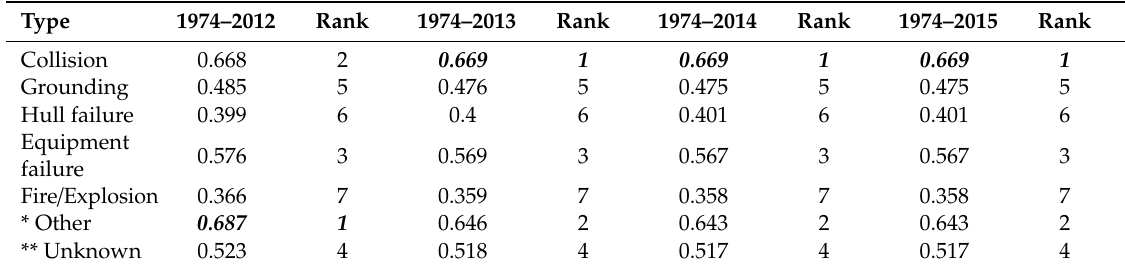
Table 7. Grey relational analysis and ranking of oil spills of 7-700 tons.